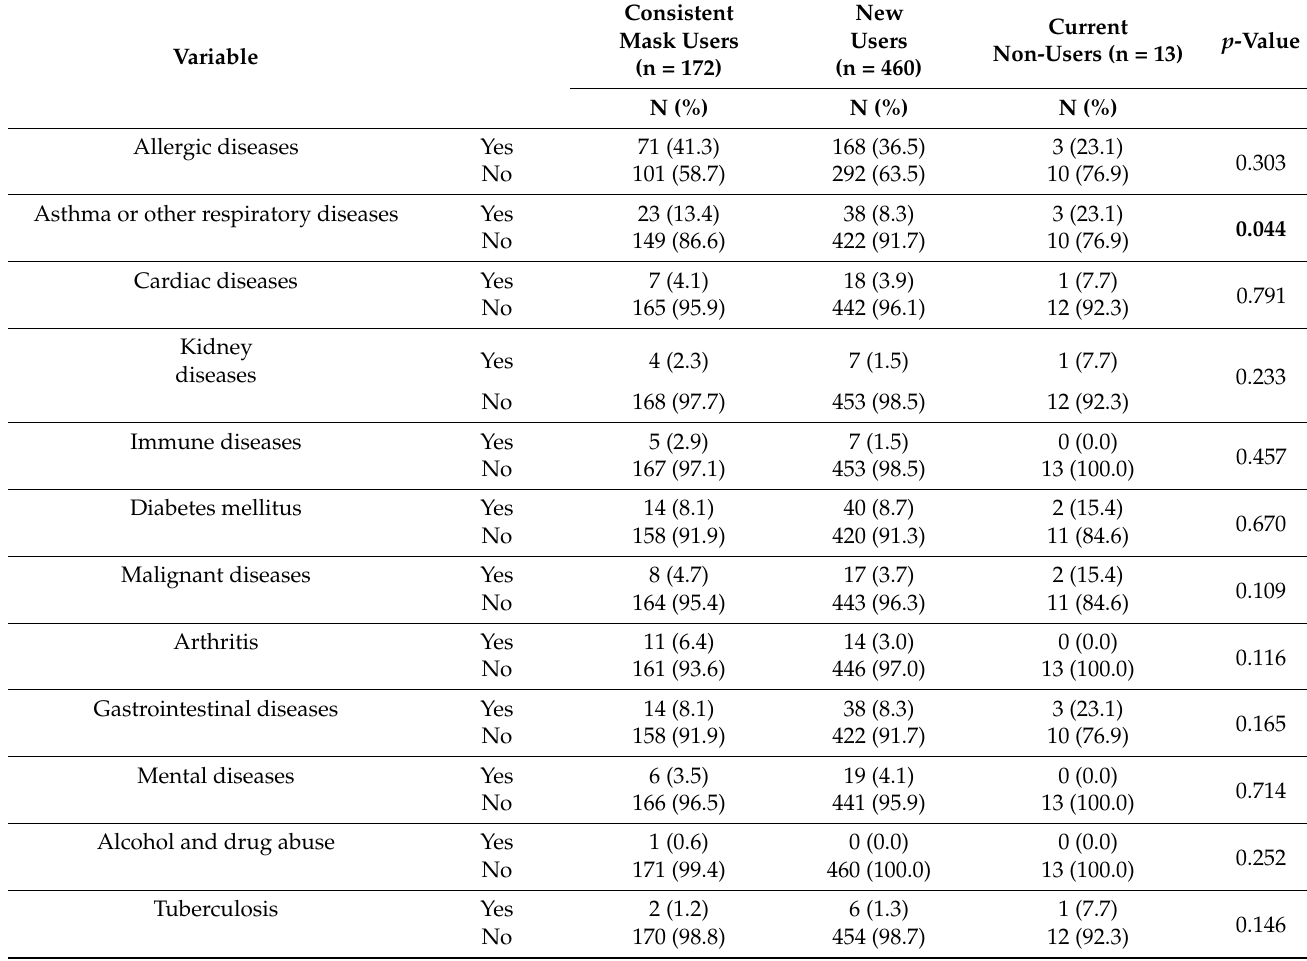
Table 4. Distribution of past medical history by mask use behavior (n = 645).